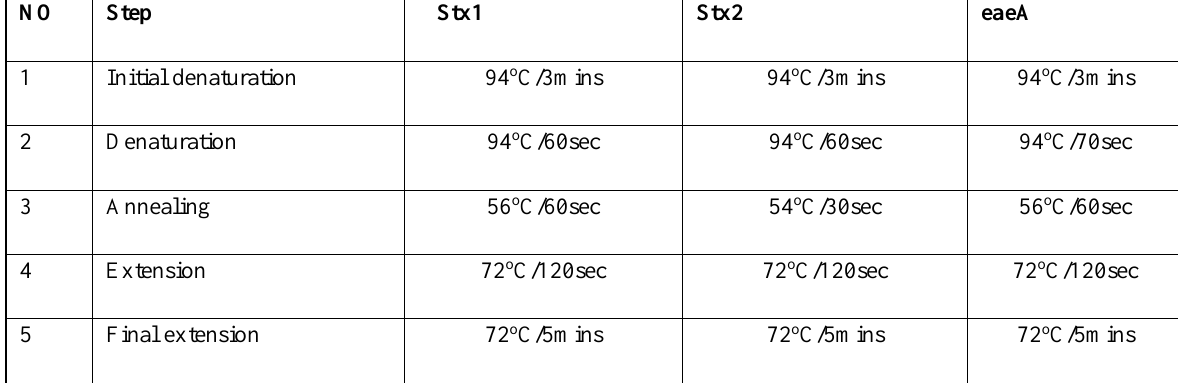
Table 2. PCR condition used for identification of virulence genes in STEC strains